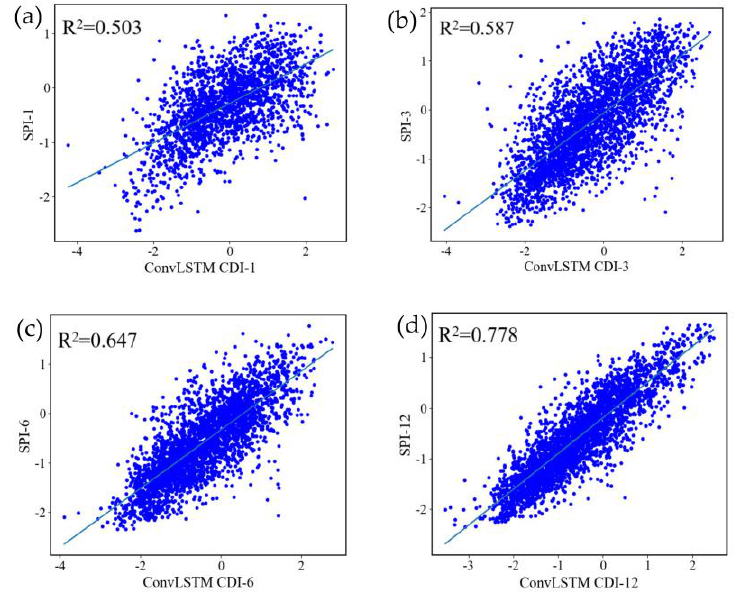
Figure 4. Scatter plots at four scales ( a ) SPI-1, ( b ) SPI-3, ( c ) SPI-6, ( d ) SPI-12 with the corresponding scale CDI output from this model.